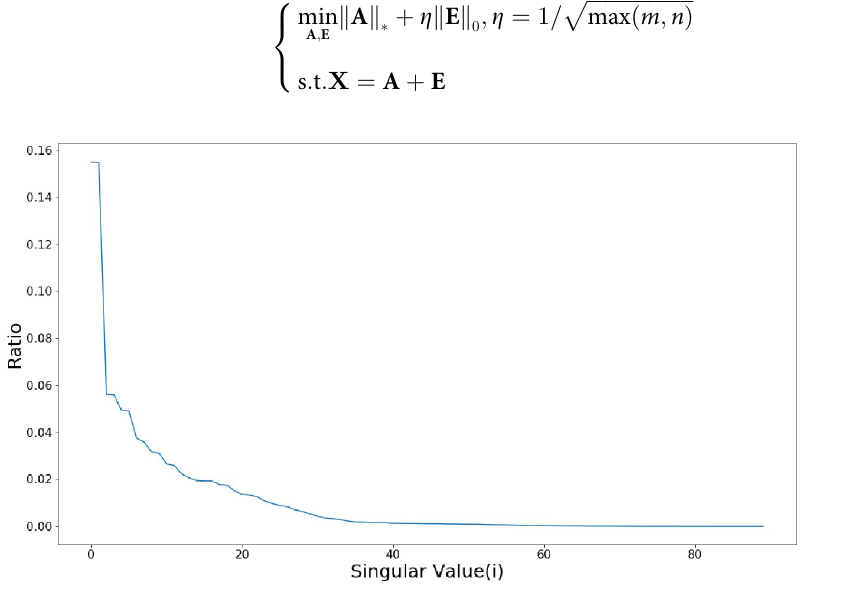
Fig 7. Proportion curves of singular